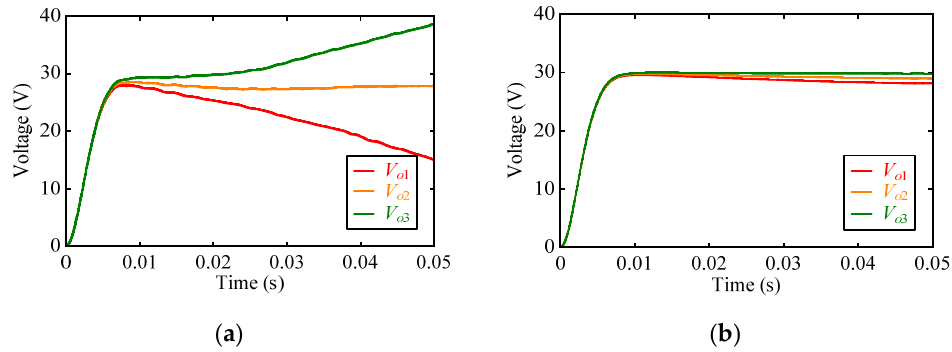
Figure 4. Output voltage waveforms under unbalanced load conditions. ( a ) Without parameter optimization. ( b ) With parameter optimization.